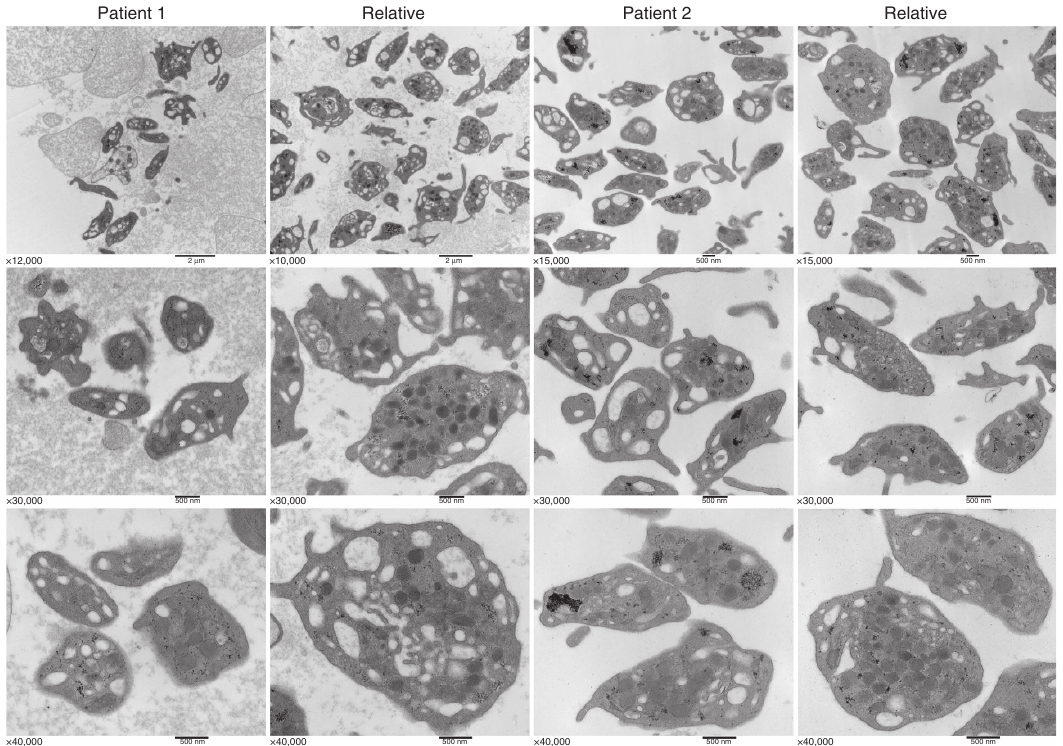
Figure 4 | Transmission electron microscopy of platelets from ARPC1B-deficient patients and normal relatives. Electron micrographs of fixed platelet sections taken at magnifications ranging from (cid:3) 10,000 to (cid:3) 40,000 (magnification on each panel; bars ¼ 500nm, top left two panel bars ¼ 2 m m) indicate the presence of generally small and morphologically variable platelets in patient samples (see also Fig. 3). Dense granules were evaluated by whole mount transmission electron microscopy (Fig.